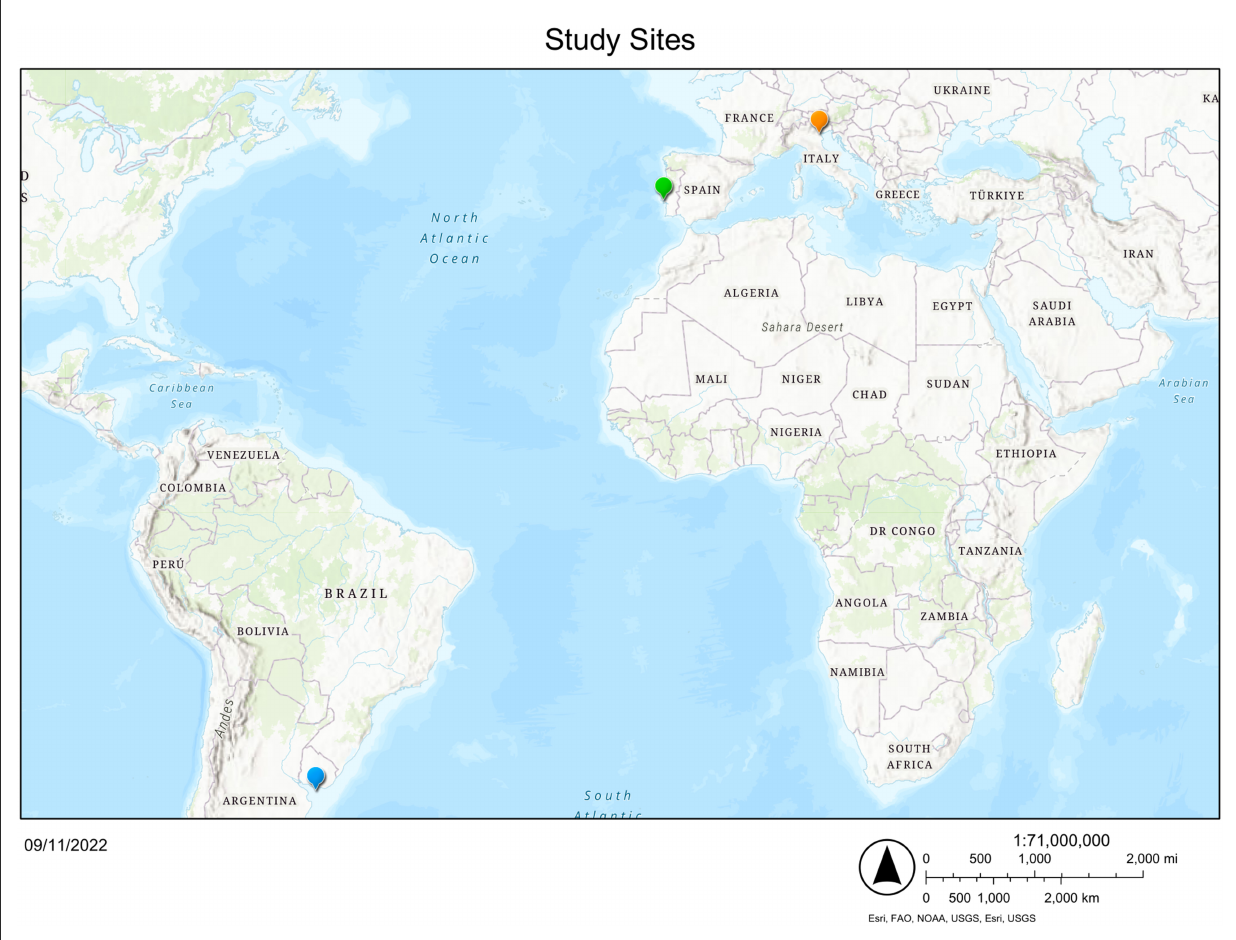
FIGURE1 Representation of the study sites: Montevideo (capital of Uruguay) is represented in blue; Lisbon (capital of Portugal) in green; Padua (city in northern Italy) in